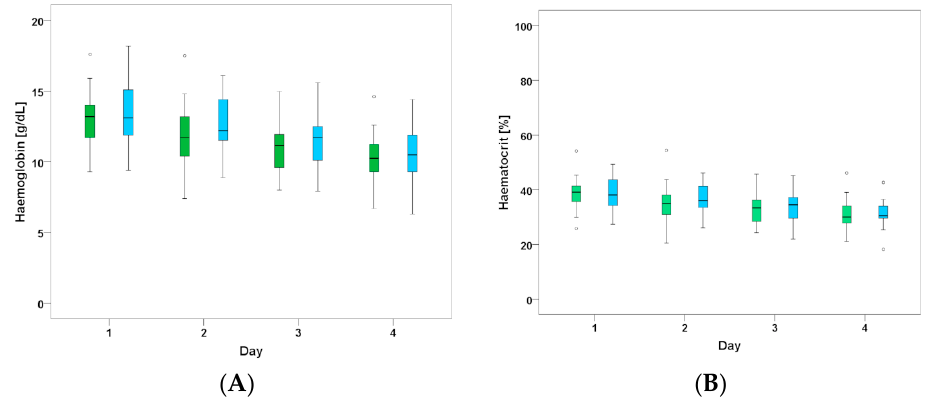
Figure 4. ( A ) Median haemoglobin for the first 4 days after index event. CANGRELOR (green) vs. ORAL-P2Y12 (blue); ( B ) Median haematocrit for the first 4 days after index event. CANGRELOR (green) vs. ORAL-P2Y12 (blue).